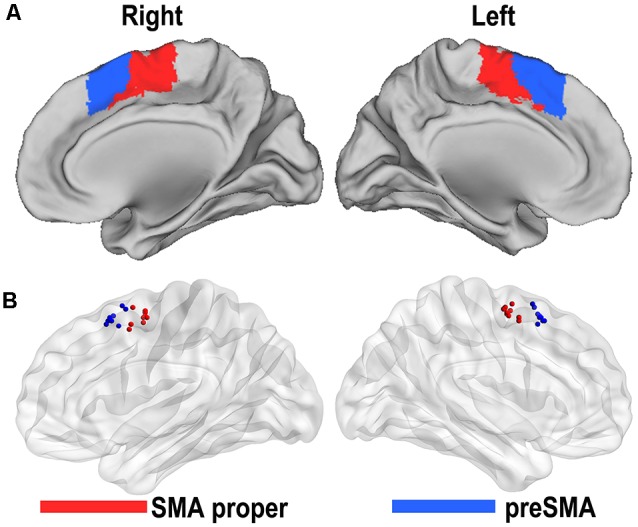
Functional connectivity-based parcellation of the human supplementary motor area (SMA). The human SMA can be subdivided into anterior (blue) and posterior (red) subregions, as shown in the maximum probabilistic maps of the right and left SMA (A). Maps are displayed on a three-dimensional brain surface using the Caret software. Centroid distribution (B) of the SMA subregions. Maps are displayed on a three-dimensional brain surface using the Brainnet Viewer (Xia et al., 2013).